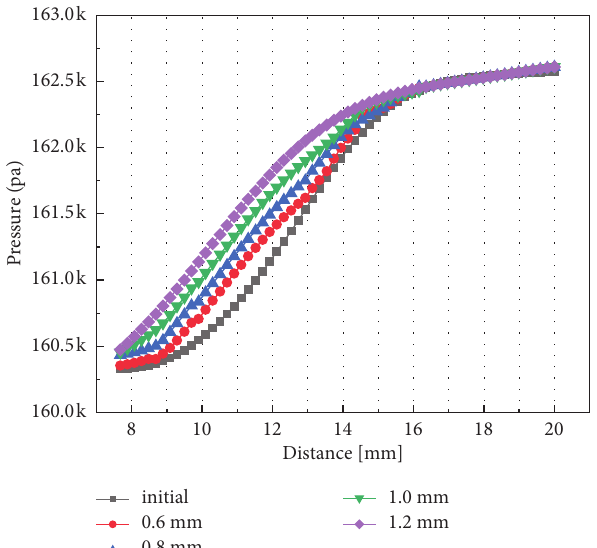
Figure 11: Local pressure distribution at the capillary